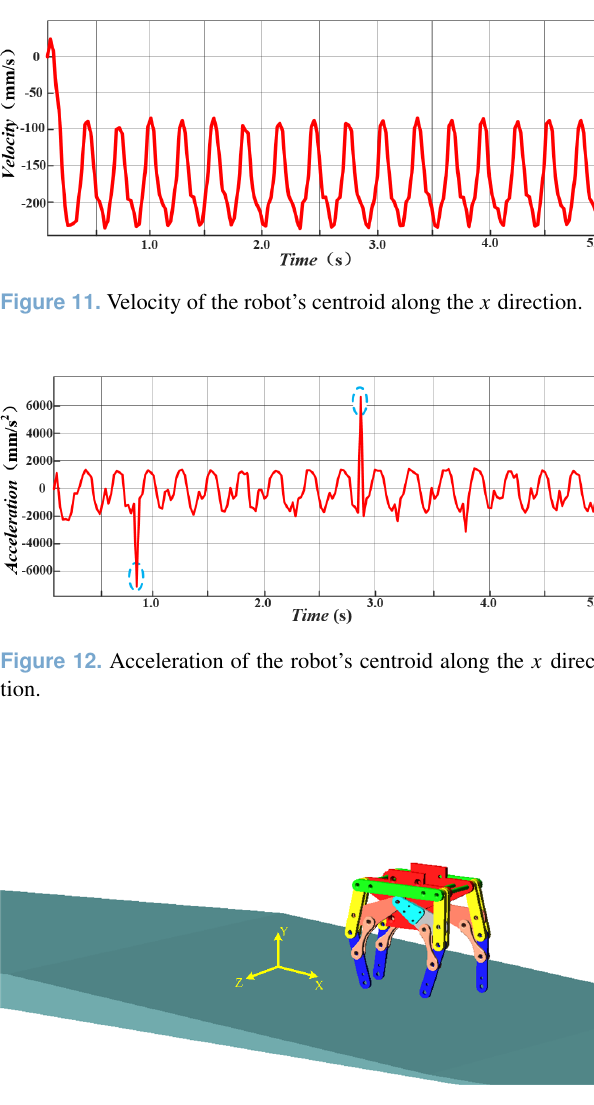
Figure 13. The simulation of